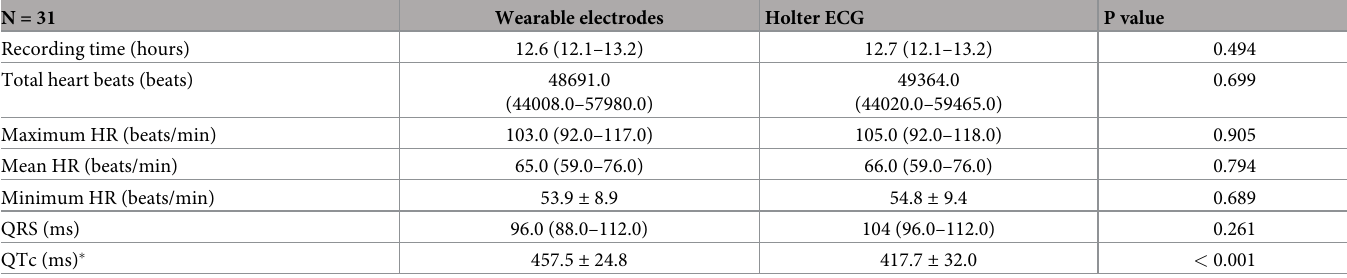
Table 2. Median of total heart beats, maximum HR, mean HR, QRS duration, and average of minimum HR, QTc interval measured by wearable electrodes embed- ded in undershirts and Holter ECG. N =